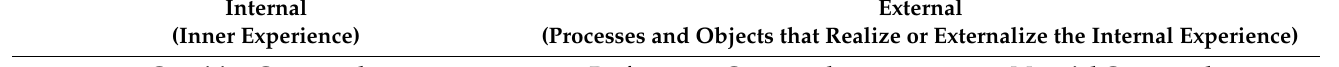
Table 2. Categories of Representations of Non-western spatial thought and expression. Source: Woodward e Lewis [6] (p.